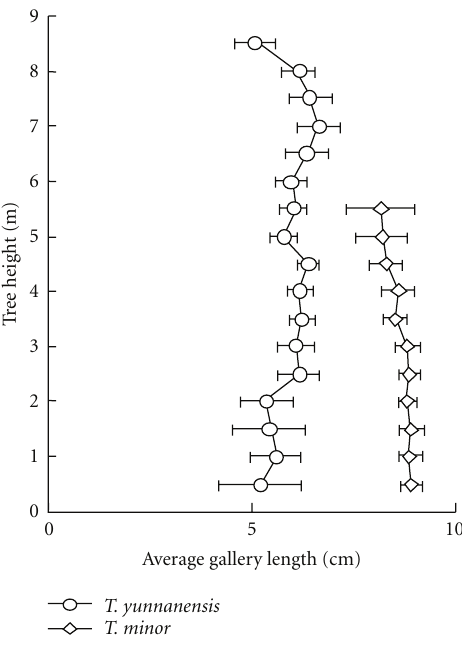
Figure 6: Average egg gallery length ( ± SE) of T. yunnanensis and T. minor along the trunks of Yunnan pines in December, 2005 (Qujing, Yunnan province, China).